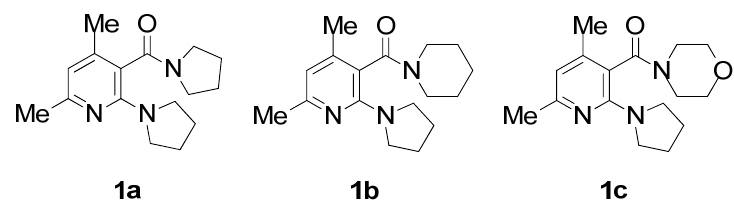
Figure 1. Synthesized oily nicotinamides 1a – c